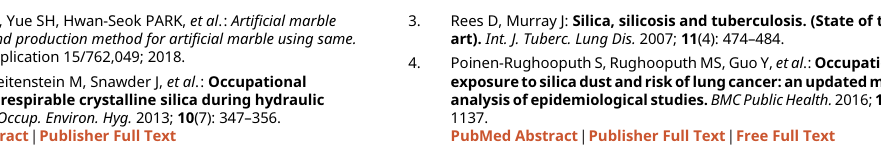
Figshare: Underlying data for ‘ Pulmonary function parameters among marble industry workers in Lahore, Pakistan ’ , https://figshare.com/s/7a24edab6fc0d64c526c.